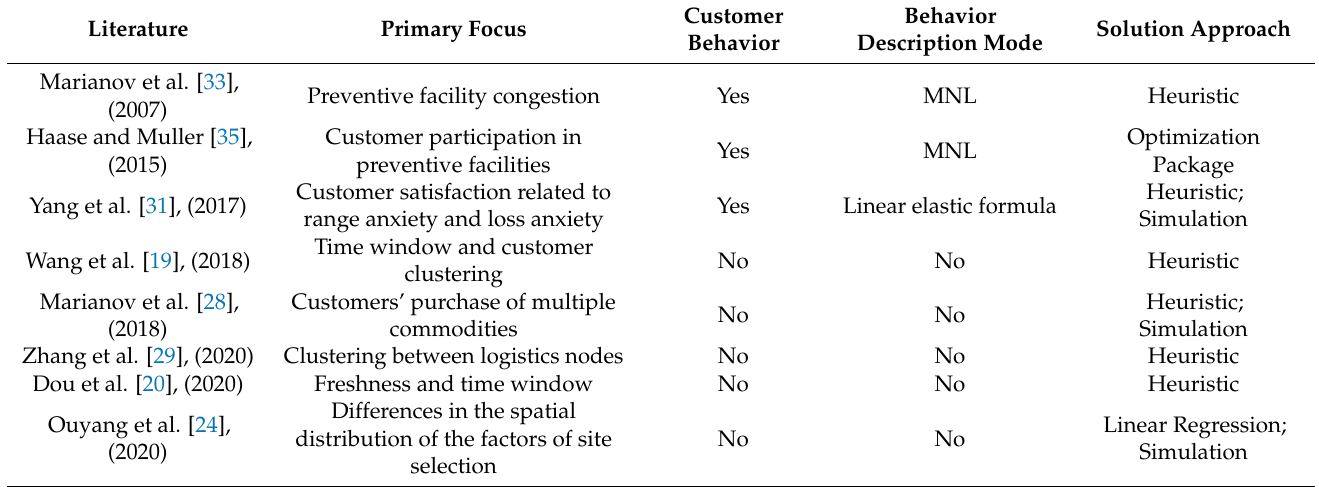
Table 1. Literature